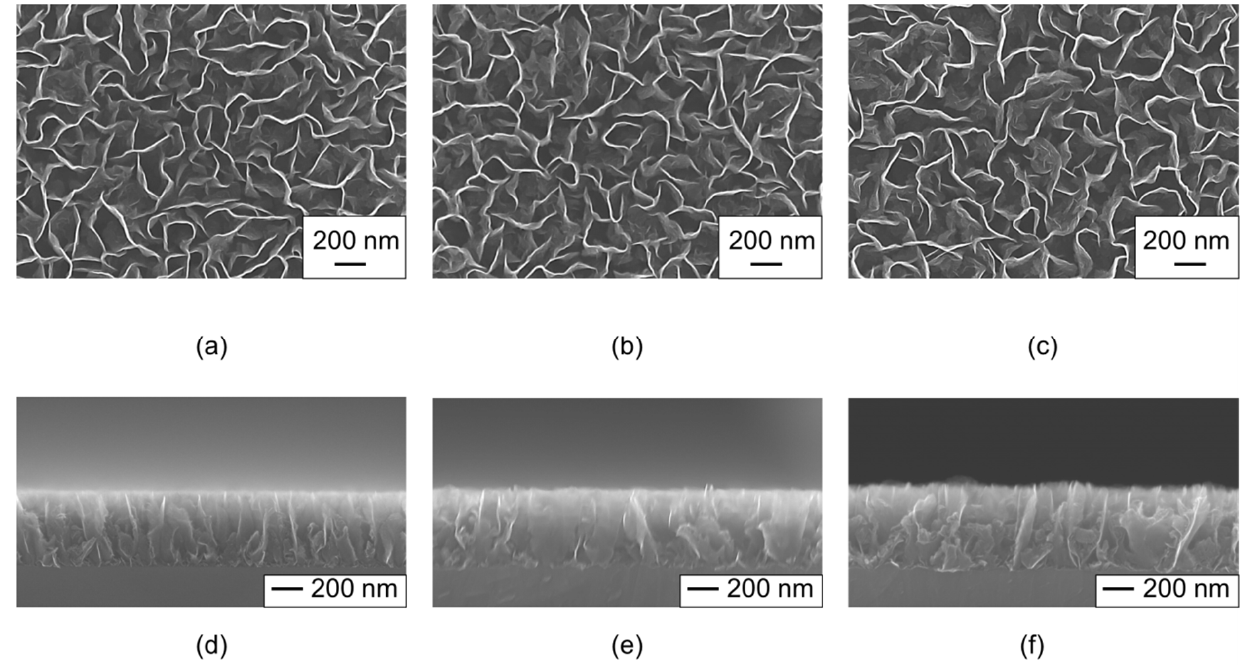
Figure 2. Scanning electron microscopy (SEM) images for ( a – c ) top and ( d – f ) cross sections of the ( a , d ) normal CNWs, ( b , e ) 5-sccm-O 2 – and ( c , f ) 10-sccm-O 2 – high-quality CNWs.